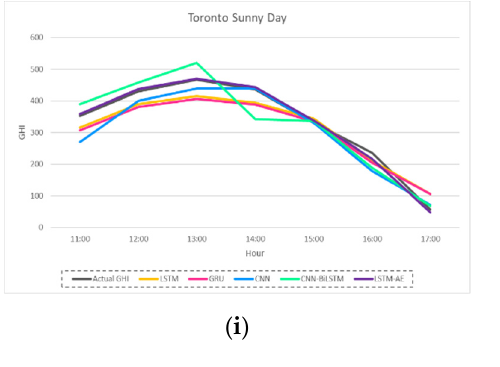
Figure 27. Sunny vs. Cloudy—actual Vs. predicted GHI of 5 models for: ( a ) Al-Jouf sunny; ( b ) Al-Jouf cloudy; ( c ) Al-Khafji sunny; ( d ) Al-Khafji cloudy; ( e ) Wadi-Addwasir sunny; ( f ) Wadi-Addwasir cloudy; ( g ) Caracas sunny; ( h ) Caracas cloudy; ( i ) Toronto sunny; ( j ) Toronto cloudy.